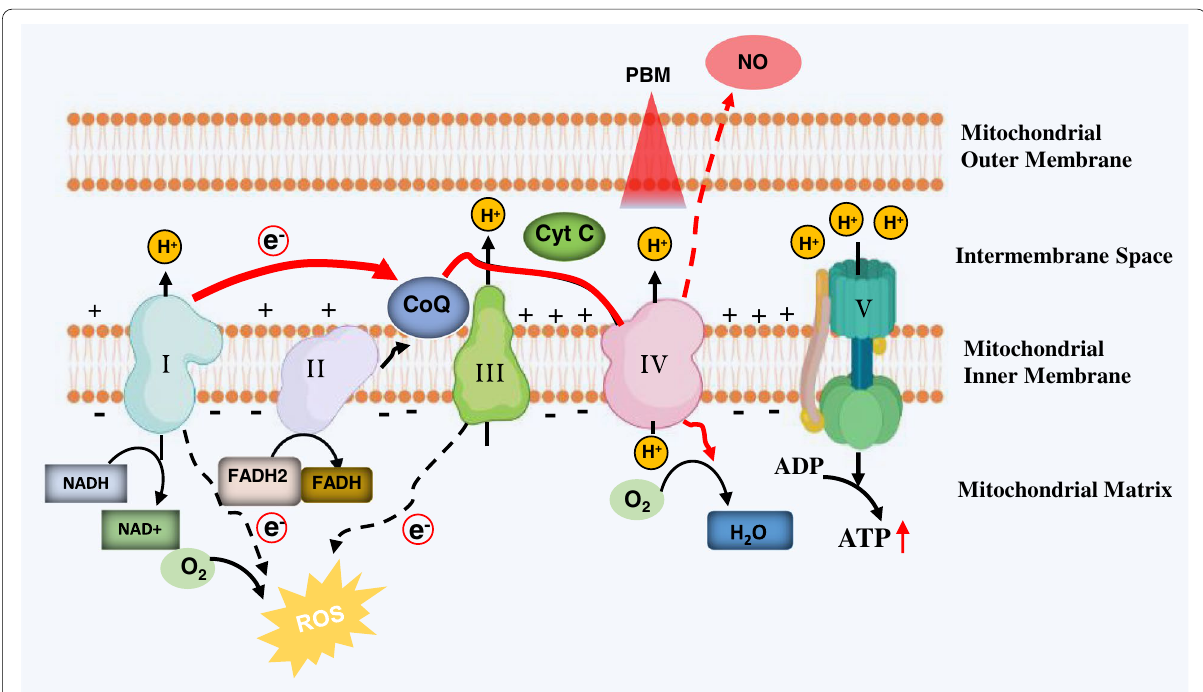
Fig. 6 PBM promotes CCO activity and increases ATP production. Nitric oxide (NO) inhibits CCO activity by non‑covalently binding with CCO. PBM treatment leads to the dissociation of NO from CCO, causing the increased activity of this complex and ATP